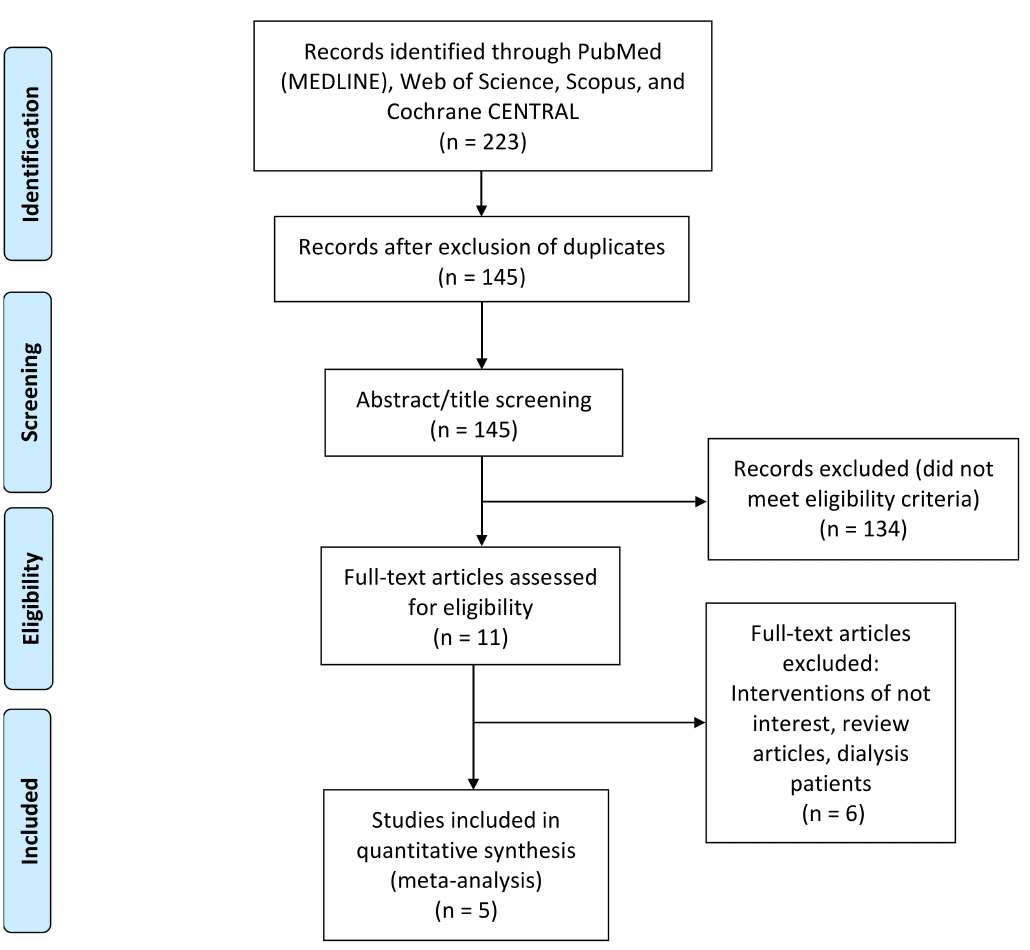
Figure 1. PRISMA flow diagram, which summarizes the literature search and the number of the obtained